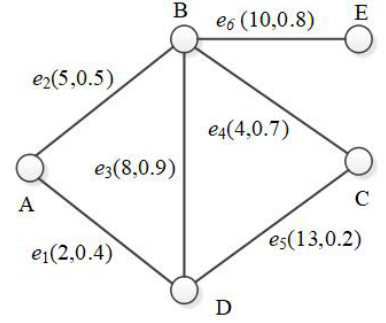
Figure 1. An example of uncertain graph: G 1